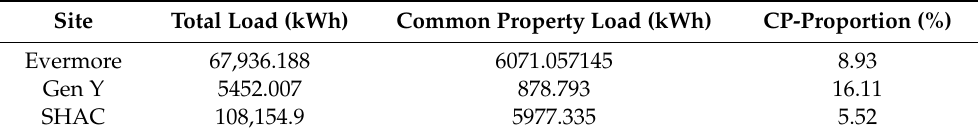
Figure 5. Monthly consumption proportion of total apartment load and CP for each site: ( a ) Evermore, ( b ) Gen Y, and ( c ) SHAC. Table 2. CP load to total load proportion in three apartment